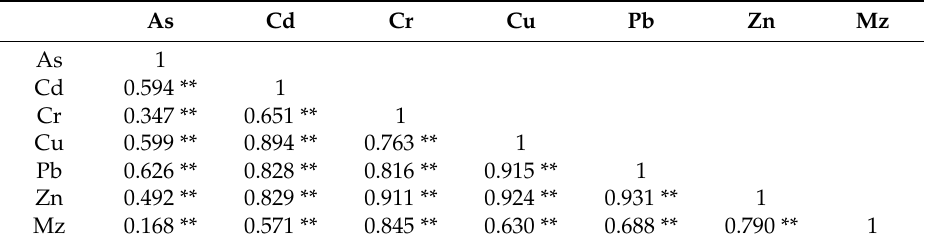
Table 3. Pearson correlation matrix of heavy metals contents and mean grain size [24].